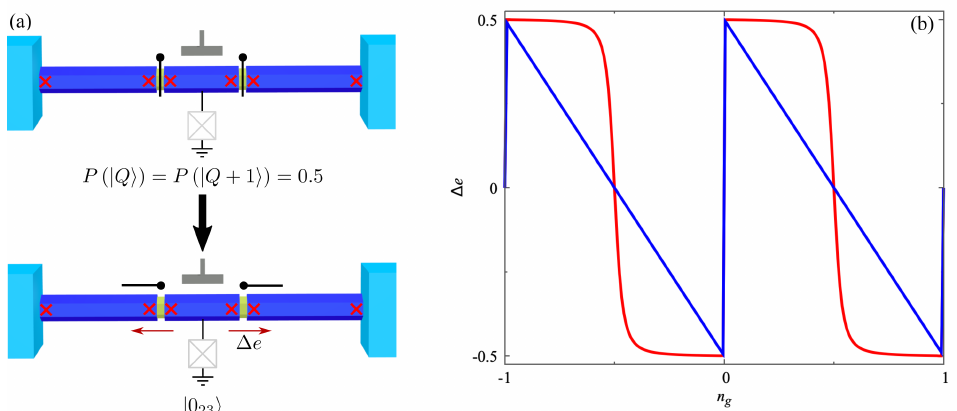
Figure 4: (a) Pump protocol where the coupling between the TSs is switched on after the fusion protocol (Fig. 2). At the end of the cycle, some charge can flow between the island and the TS leads (red arrows). (b) Number of electrons pumped out through the JJ FET per fusion cycle for E max